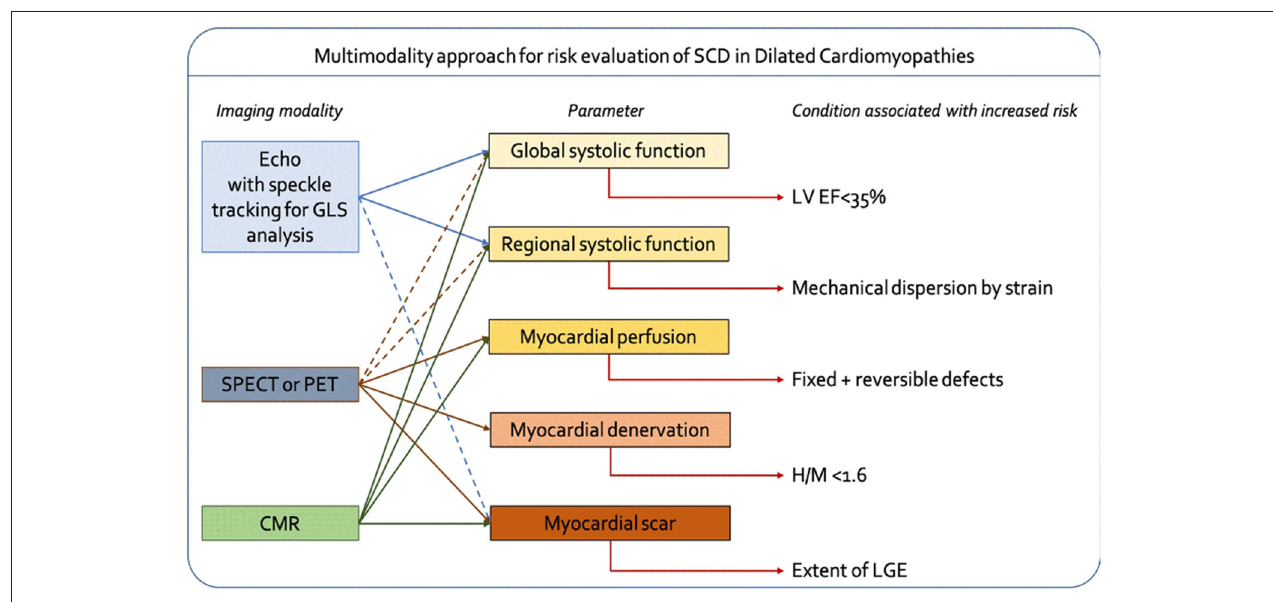
FIGURE 2 | Framework for combining multiple imaging modalities to improve accuracy of predicting sudden cardiac death (SCD) in patients with dilated cardiomyopathies [from Bandera et al. (